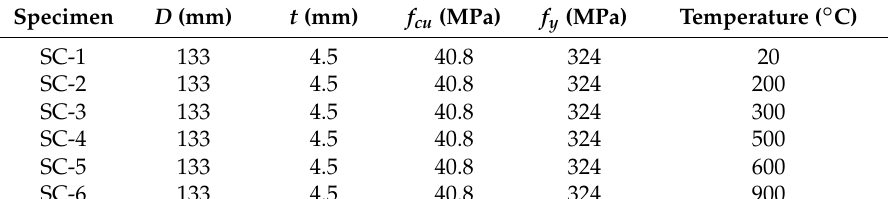
Table 6. The parameters of the specimens in ref. [30].